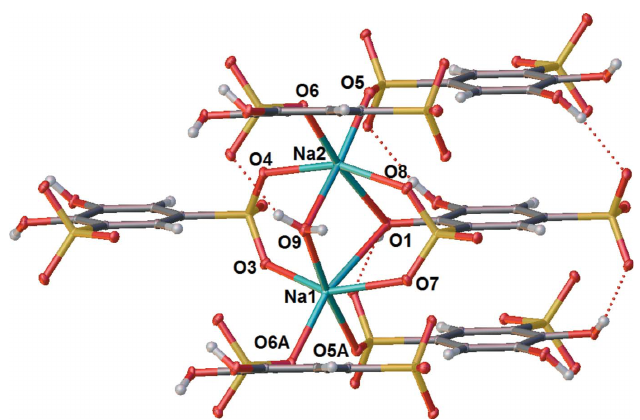
Figure 4 Displacement ellipsoid plot of Na 2 (tiron) (cid:2) H 2 O illustrating the pseudo- octahedral coordination geometry around the Na ions. Ellipsoids shown at the 50% probability level. H atoms are shown as spheres. Atom labels with the suffix A are related by translation by one unit cell.